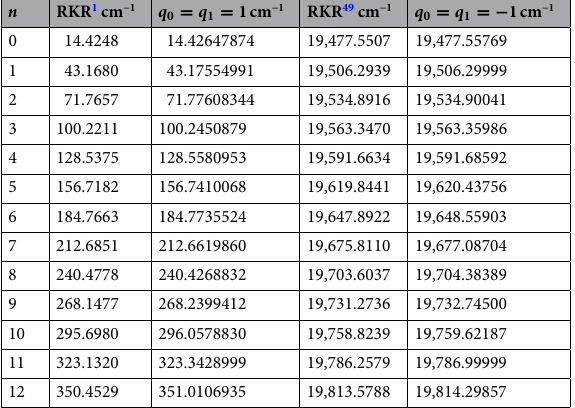
Table 1. Comparison of theoretical values with experimental values for the vibrational energy levels of the modified deformed exponential-type molecular potential for 3 3